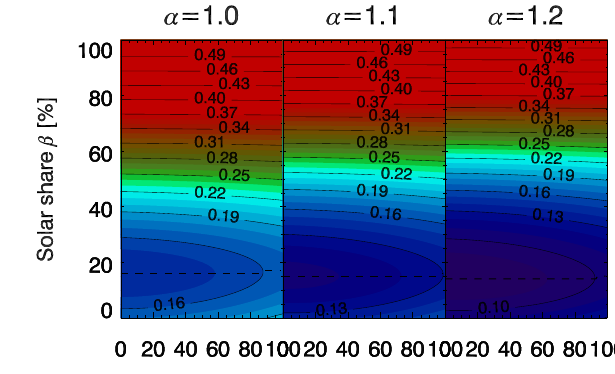
Figure 2. Storage energy needs in units of the consumption in Eu- rope. They are computed with unlimited transmission in depen- dency of the solar share β and the wind onshore share γ for in- stallation factor α = 1.0, 1.1 and 1.2. The dashed lines indicate the optimal solar share in dependency of the wind onshore share.